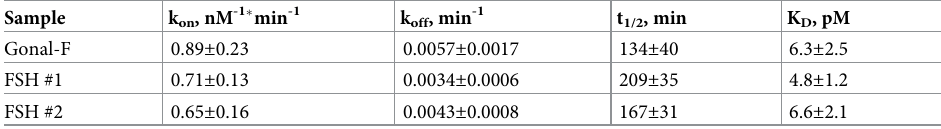
Table 3. Summary of derived specific in vitro activities for one FSH sample, slope ratios and upper asymptote ratios. No (Replication) Specific activity (IU/ μ g) Specific activity % of standard Slope ratio (sample/standard), % Upper asymptote ratio (sample/standard), % 10.5 12.2